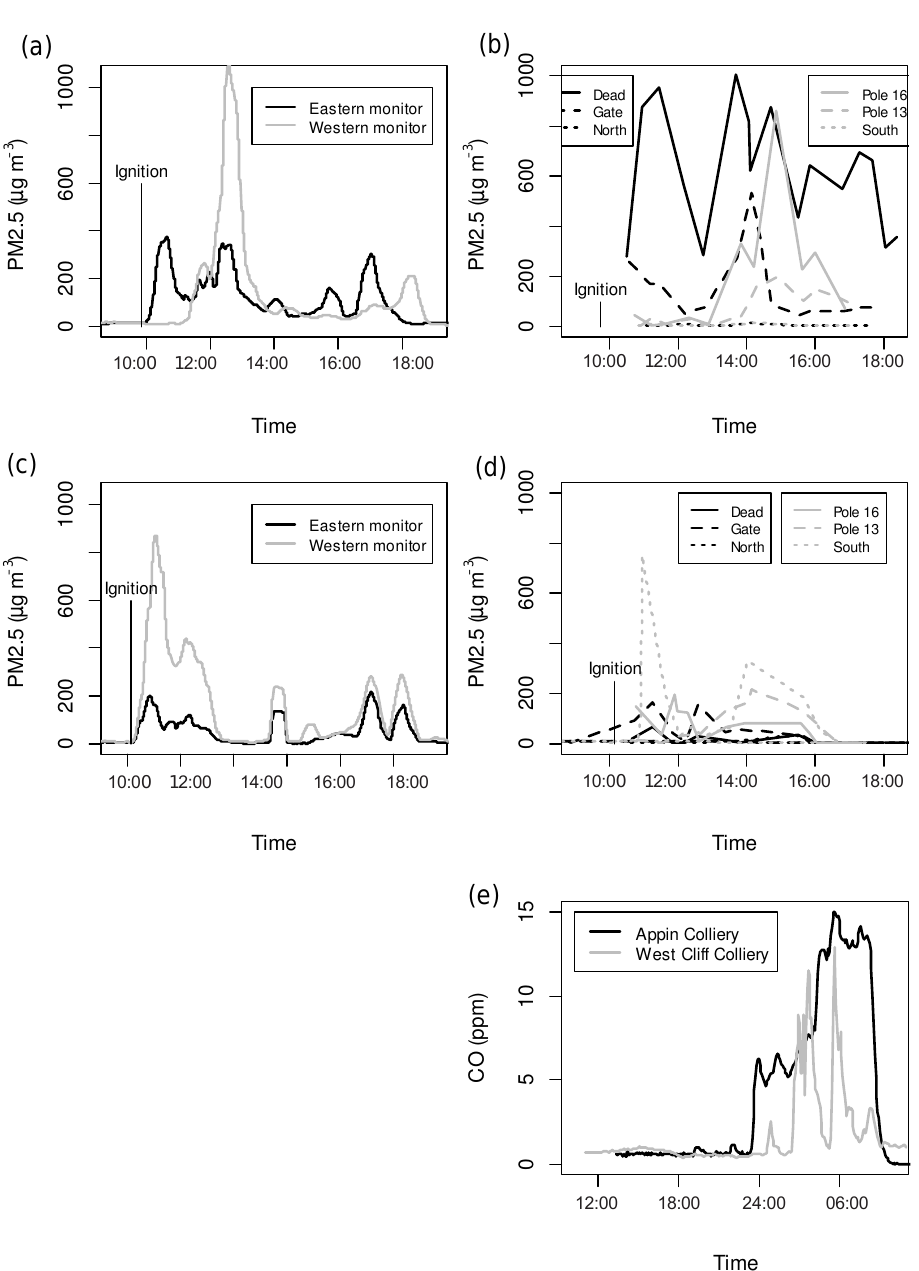
Figure 7. Time traces of air pollutants during the fires: (a) PM 2 . 5 measured at the reference monitors for the 52ha fire and (b) 700ha fire; (c) PM 2 . 5 measured by handheld monitor at different locations in the 52ha fire and (d) 700ha fire; and (e) CO concentrations measured at two mine entrances during the 700ha